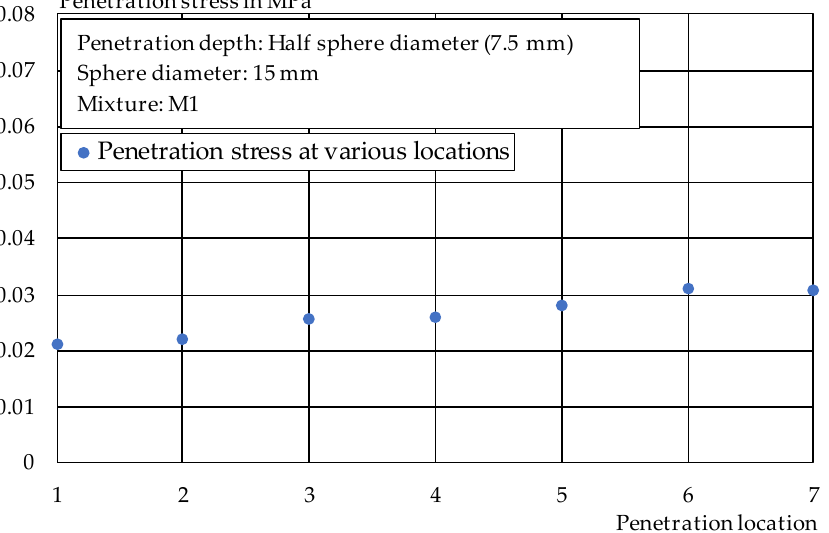
Figure 13. Resistance stresses at the time when the penetration depth corresponds to the sphere radius of 7.5 mm (sphere diameter 15 mm), mixture M1.